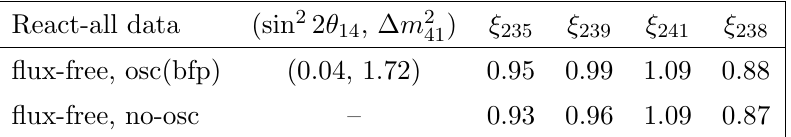
Figure 4 . (cid:1) (cid:31) 2 of the combined reactor (left) and global ( with respect to all parameters except (cid:1) m 2